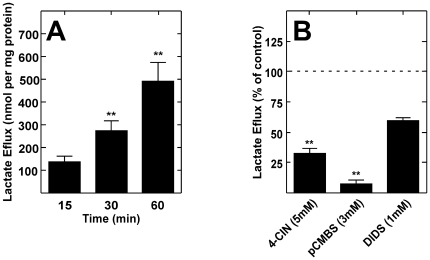
Cultured tanycytes release lactate.
A, Lactate efflux at 5 mM glucose. Lactate efflux increased throughout the incubation time. B, Analysis of lactate efflux in the presence of several inhibitors pre-incubated for 15 min at 37°C. Lactate efflux decreased significantly with 4-CIN and pCMBS. **p<0.001, one tailed t-test. Results represent the average ± SD of three independent experiments.